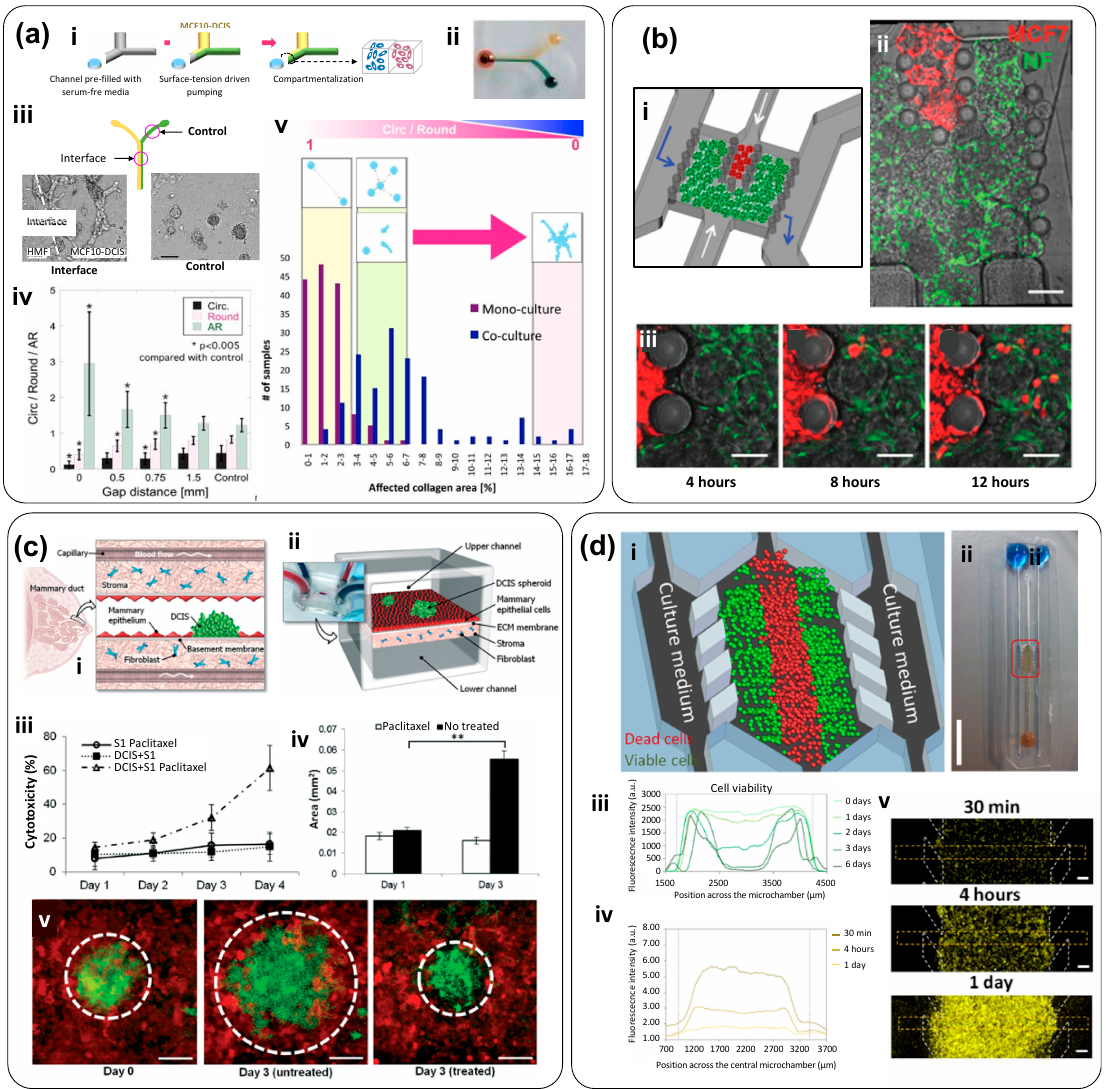
Figure 5. Tumor-on-chip (TOC) systems in which cancerous and normal microtissues share an interface. ( a ) Crosstalk between cancer cells and fibroblasts in a Y-shaped TOC: (i) scheme and (ii) actual device. (iii) Human mammary fibroblasts (HMF) and breast cancer (MCF10-DCIS) cells establish a cross-talk at the interface between the cancerous and normal microtissue sections. Scale bar: 30 µ m. (iv) Circularity, roundness, and aspect ratio (AR) of MCF10-DCIS cancer cells as a function of their distance from the interface. (v) Image analysis characterization of invasiveness. Taken from reference [33]; ( b ) On-chip activation of stromal tissue by crosstalk with cancerous tissue [35]: (i) schematic representation of the device and (ii) actual micrographs of normal cells (expressing GFP) and cancer cells (expressing RFP). Scale bar: 100 µ m. (iii) Time sequence showing cancer cell migration and invasion. Scale bars: 100 µ m; ( c )